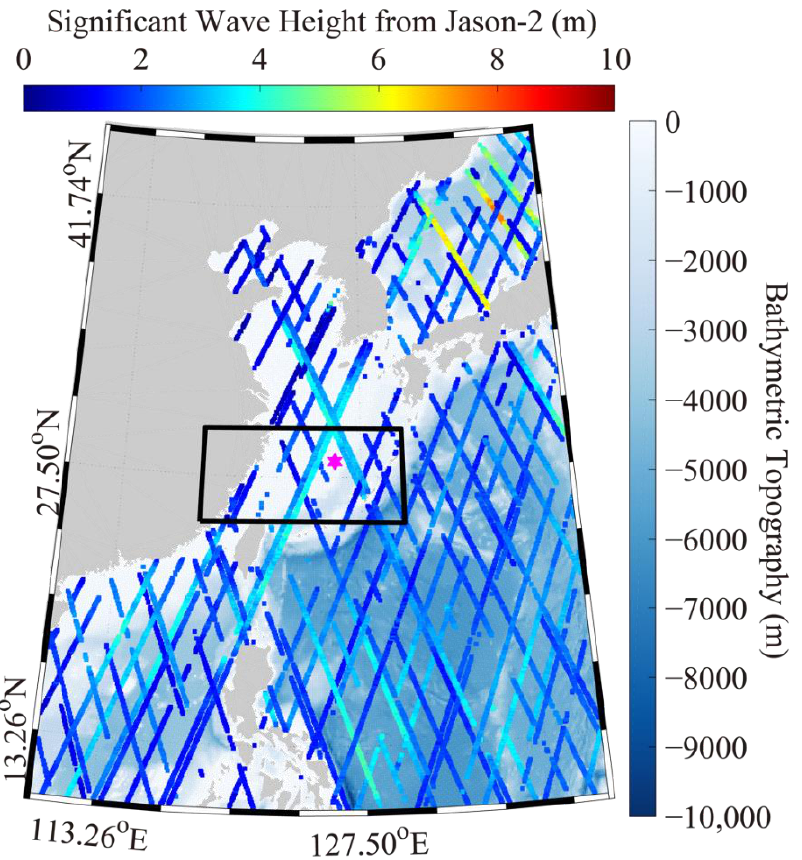
Figure 4. The significant wave height (SWH) following the footprints of the Jason-2 altimeter in January 2018 overlaid with the water depth, in which the pinkish marks represent the shipwreck position, and the black rectangle represents the available measurements for validating the model- simulated SWH from SWAN.